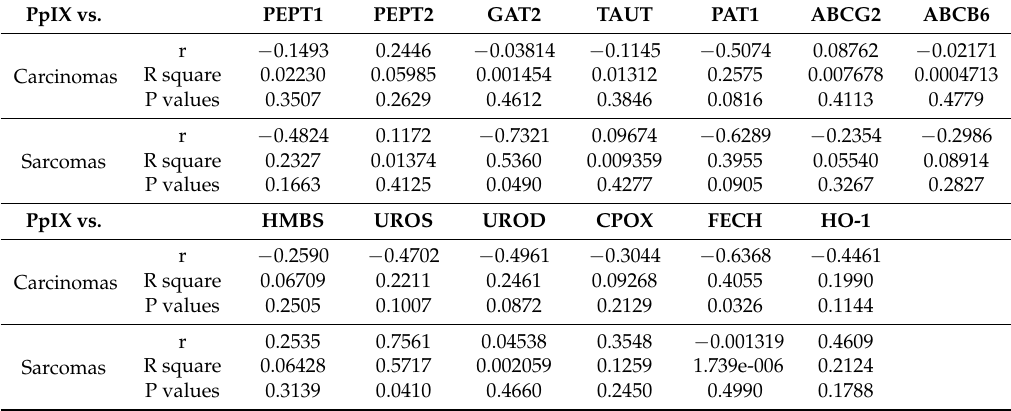
Peptide transporter 1 (PEPT1), peptide transporter 2 (PEPT2), GABA transporter 2 (GAT2), taurine transporter (TAUT), H+/amino acid transporter 1 (PAT1), ATP-binding cassette transporter G2 (ABCG2),